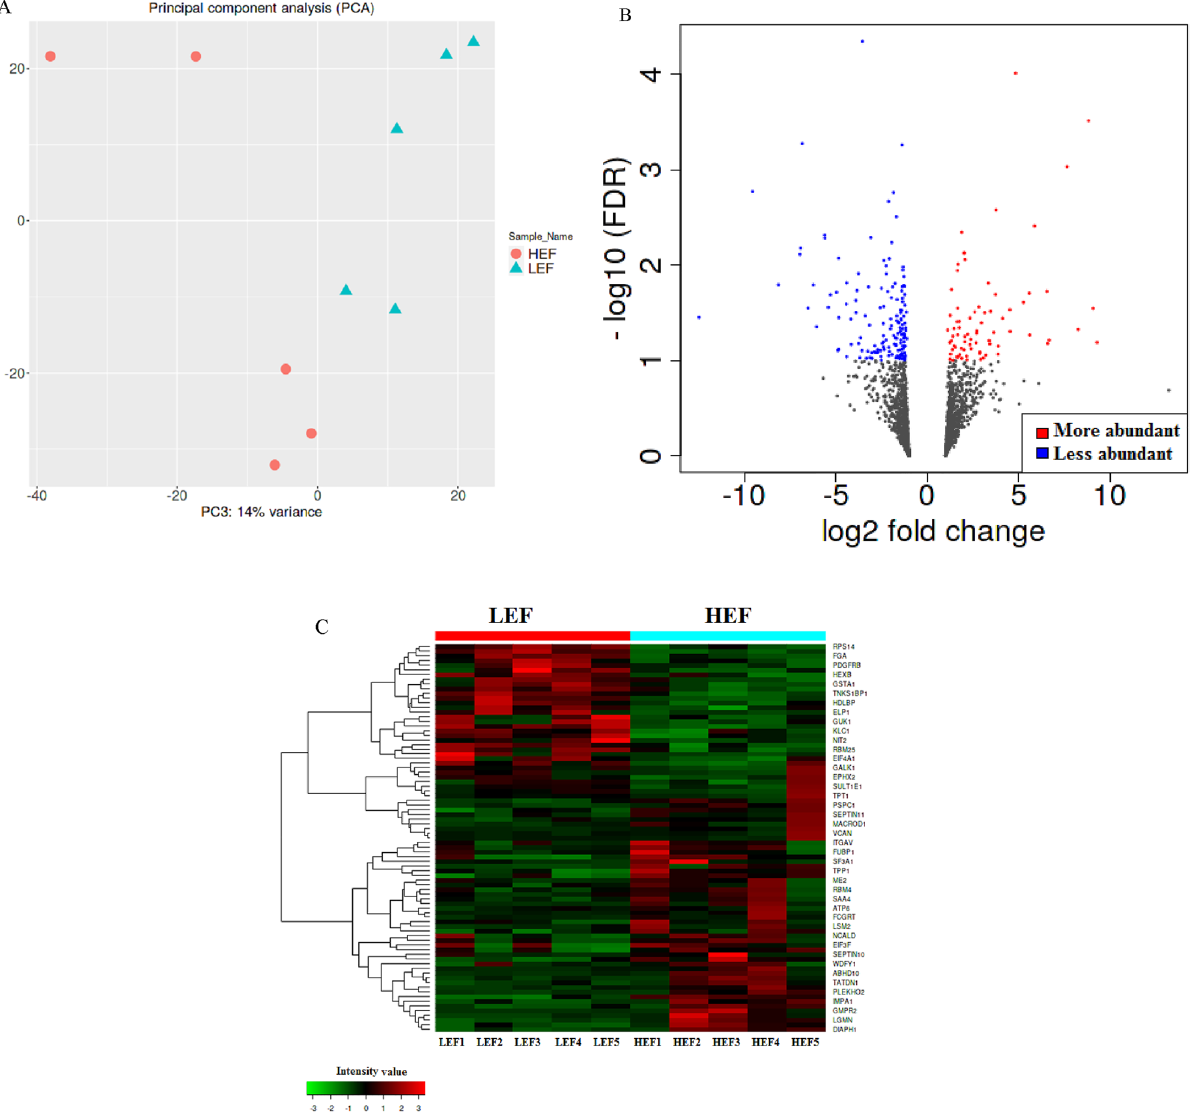
Figure 2. ( A ) Principle component analysis of HEF versus LEF dairy cows measured by IDEP9.1 server showing 14% variance. LEF samples represented in red circles whereas HEF samples represented in green triangles. ( B ) Volcano plot analysis of HEF versus LEF dairy cows generated by IDEP9.1 server with P value (< 0.05) on Y-axis and FDR (± 1.5) on X-axis. Each dot represents one protein and red color indicates more whereas blue color indicates less abundant proteins in AT. ( C ) Heatmap of AT analyzed by IDEP9.1 server where low peptide intensity represented by green color whereas high peptide intensity was measured in red color. Each cow in the study is numbered and represented in